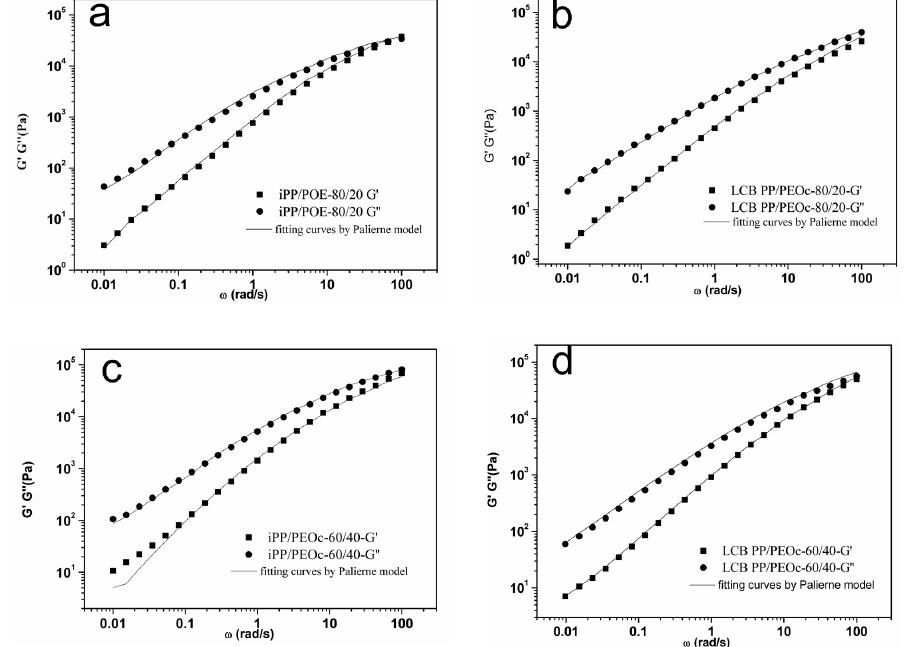
Figure 13. Palierne model fitting curves for the experimental dynamic moduli of the ( a ) iPP/PEOc-80/20 blend; ( b ) LCB PP/PEOc-80/20; ( c ) iPP/PEOc-60/40 blend; and ( d ) LCB PP/PEOc-60/40 blend at 180 °C.